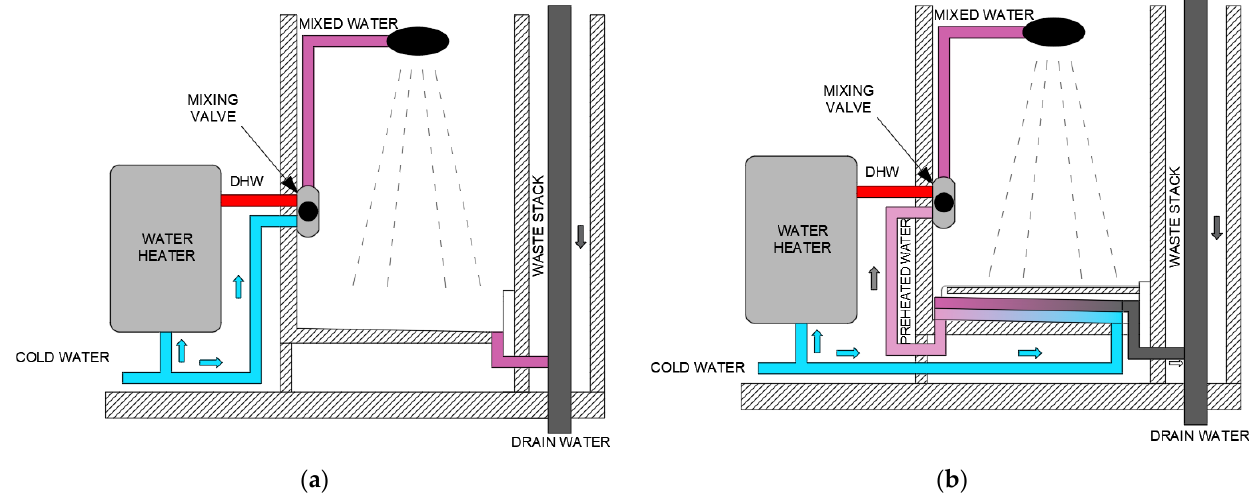
Figure 3. Installation example of a heat exchanger mounted under the floor shower drain: ( a ) Installation without a shower heat exchanger; ( b ) Installation with a shower heat exchanger (DHW—domestic hot water).